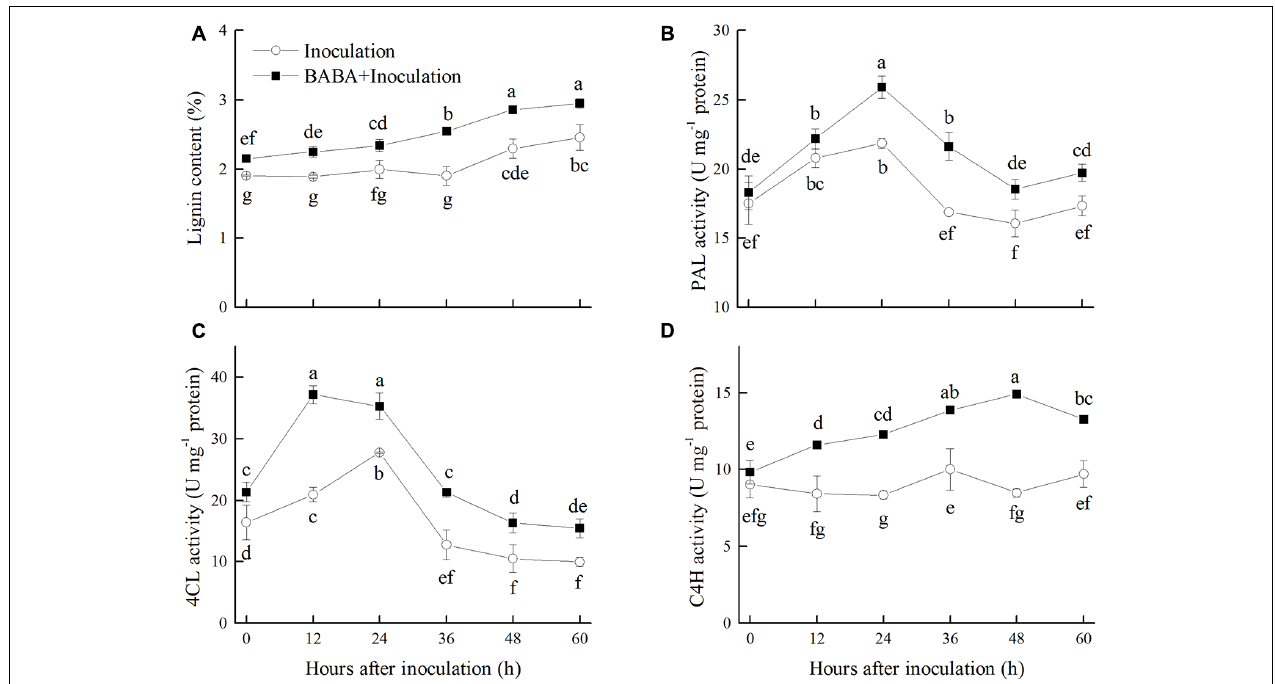
FIGURE 3 | Changes in lignin content (A) , activities of phenylalanine ammonia lyase (PAL) (B) , 4-coumaryl CoA ligase (4CL) (C) , and cinnamate 4-hydroxy (C4H) (D) in peach fruit inoculated with Rhizopus stolonifer (Inoculation) or pretreated with 50 mM BABA and then inoculated with R. stolonifer (BABA + Inoculation) during storage at 20 ◦ C. Data are expressed as the mean of triplicate samples. Vertical bars represent the standard errors of the means. Letters without the same letter above the bars indicate significant differences at P <